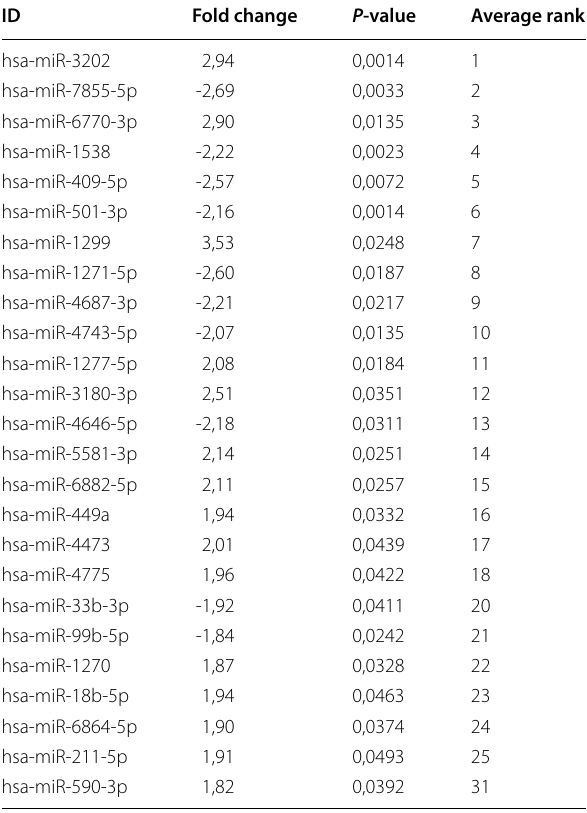
Table 3 DE miRNAs in ictal PBMC samples compared to interictal ones. Differential expression was tested against a fold change threshold of 1.2 and a p-value threshold of 0.05. Average rank was calculated as the mean ranks of miRNAs based on fold change and